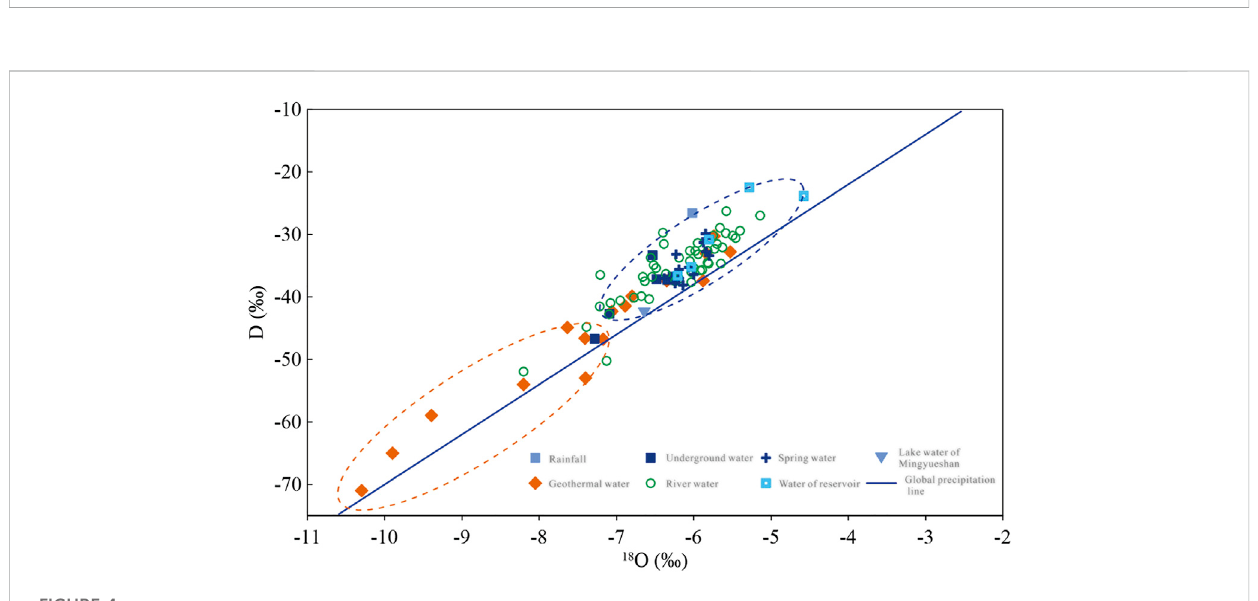
FIGURE 4 Histograms of thermal conductivities in the Wugongshan